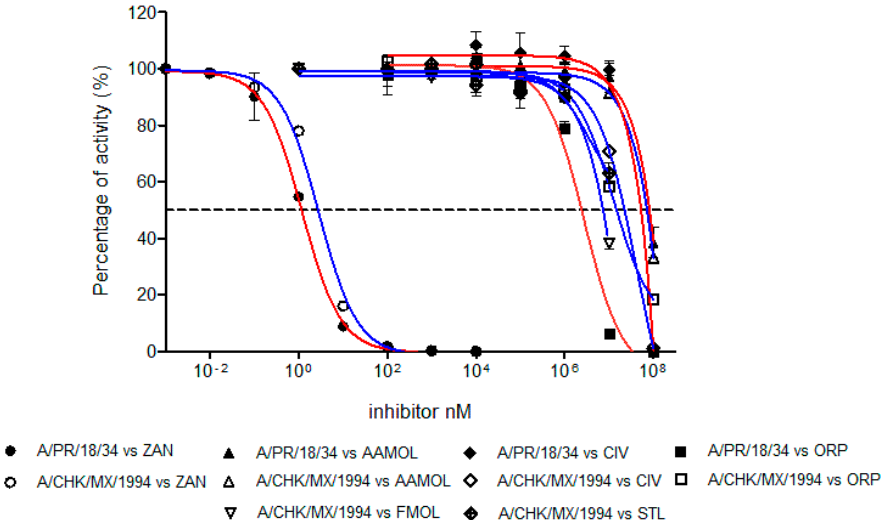
Figure 7. Concentration-activity diagram for the viral supernatant which was used along with the inhibition control zanamivir. They were prepared with 0.3 mM MES buffer and 4 mM CaCl2 at pH 6.5. FMOL and STL molecules were evaluated for H5N2 avian influenza virus while other molecules and the control were evaluated with both viral subtypes: human H1N1 and avian H5N2. The IC 50 of each curve was graphed and determined with the GraphPad Prism 6.04 program. Nonlinear regression analysis was performed to obtain trend lines. Data represent the average ± SD of three independent experiments. The values obtained from the IC 50 are reported in Table 1.